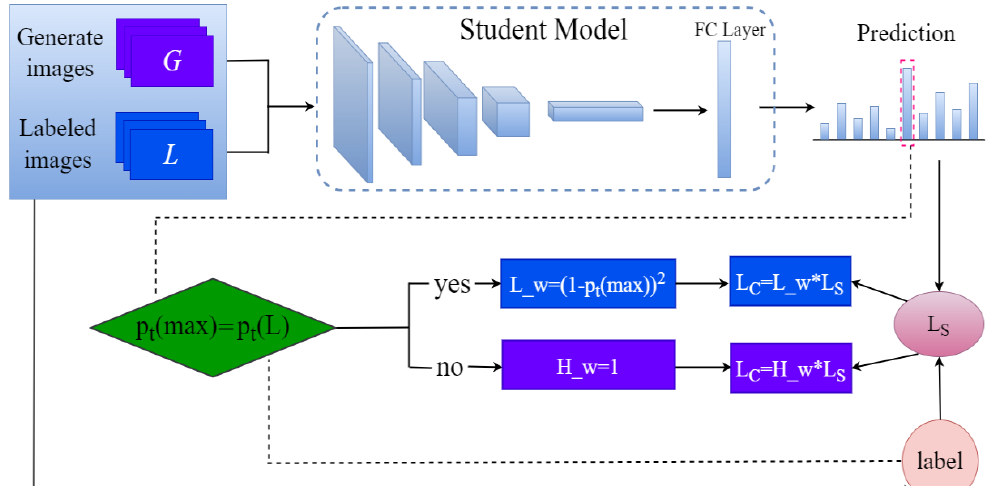
Figure 6. Supervisory loss in our semi-supervised model.